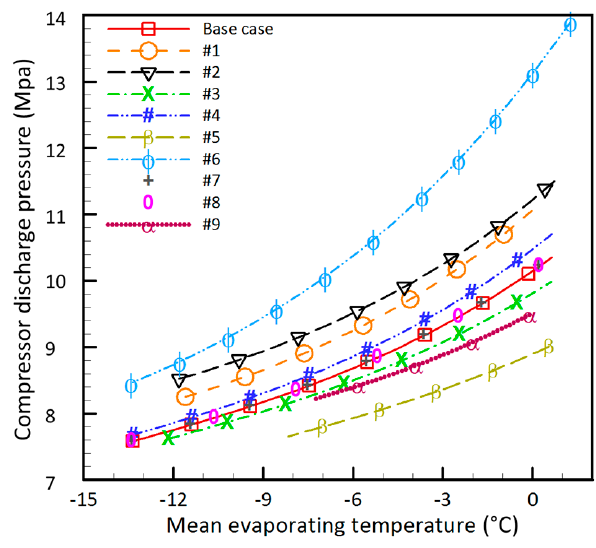
Figure 7. Discharge pressure ( P discharge_comp ).